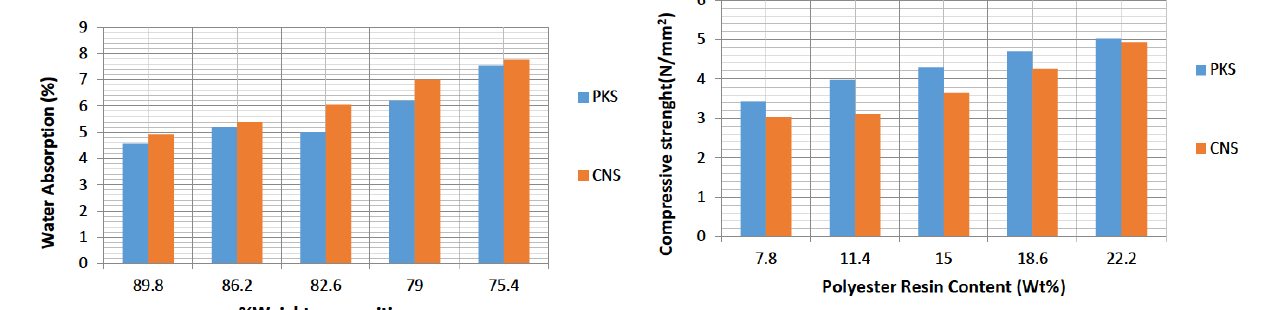
Figure 17: Compressive strength value of PKS & CNS for 250 µ m